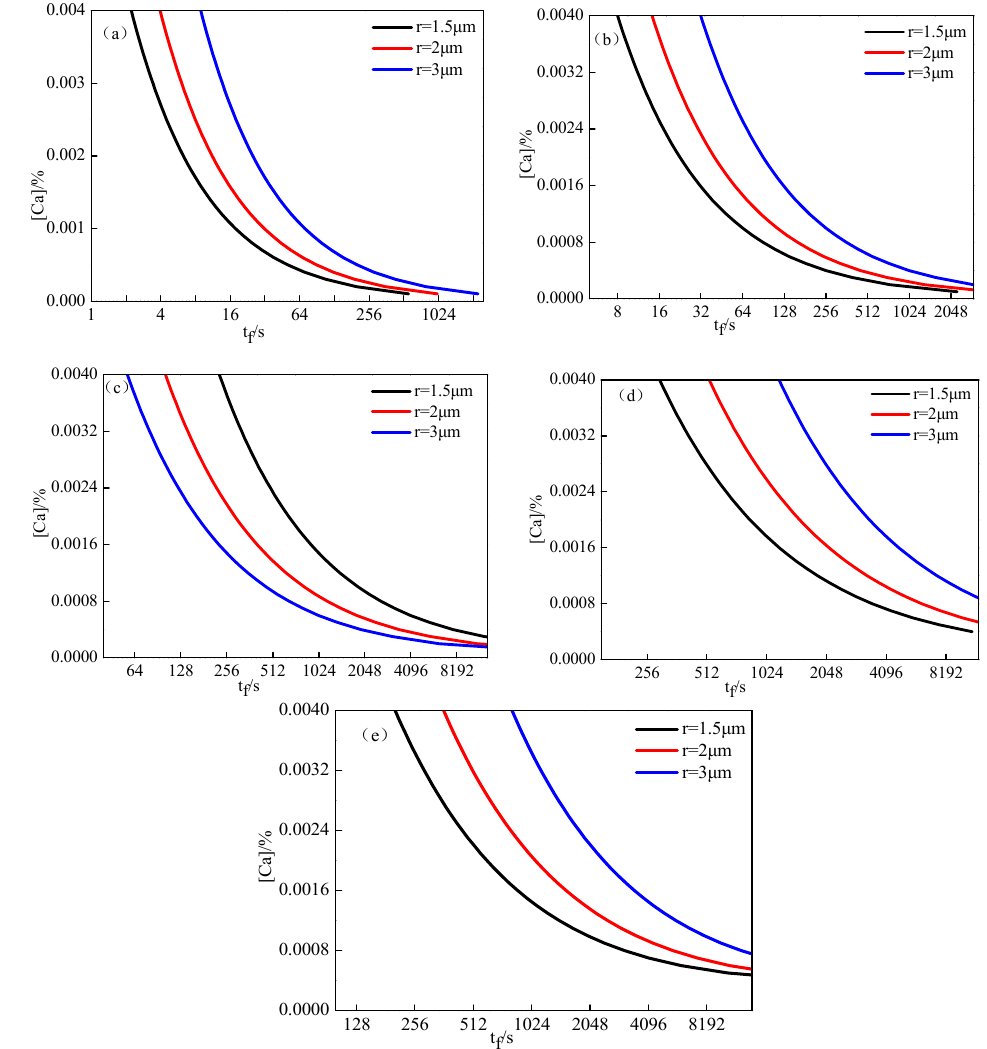
Figure 10. Relationship between Ca content in molten steel and complete modification times for inclusions with different compositions: ( a ) Al 2 O 3 modified into CA 6 ; ( b ) CA 6 modified into CA 2 ; ( c ) CA 2 modified into CA; ( d ) CA modified into C 12 A 7 ; ( e ) C 12 A 7 modified into C 3 A.